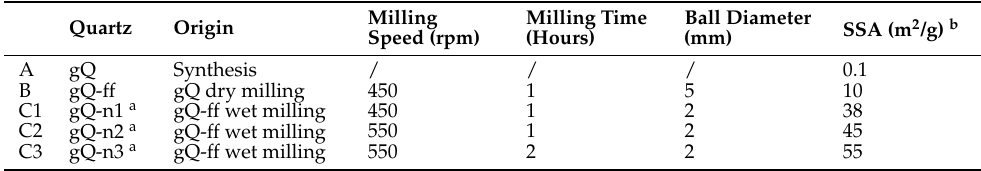
Table 1. Milling parameters and specific surface area of the quartz particles.